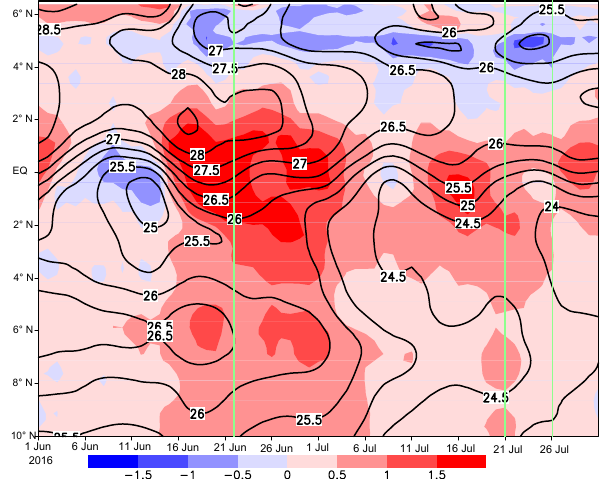
Figure 3. Daily SST behaviour over the eastern tropical Atlantic during June–July 2016. SSTs ( ◦ C) are averaged between 10 ◦ W and 4 ◦ E (see box in Fig. 2) and shown as absolute values (lines) and anomalies (shading). Basis is the Reynolds Optimal Interpo- lated SST dataset and anomalies are relative to 1981–2016 as in Fig. 2. Only values greater than the SST Reynolds daily error esti- mation are plotted. The four phases of the DACCIWA campaign are marked with thin green